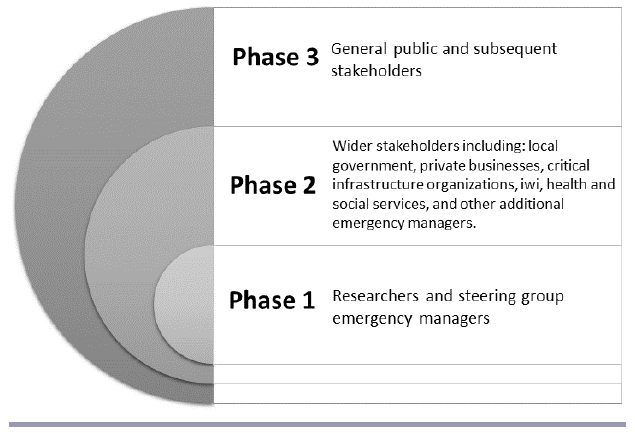
Fig. 3 . Nested phases of Project AF8 engagement process.